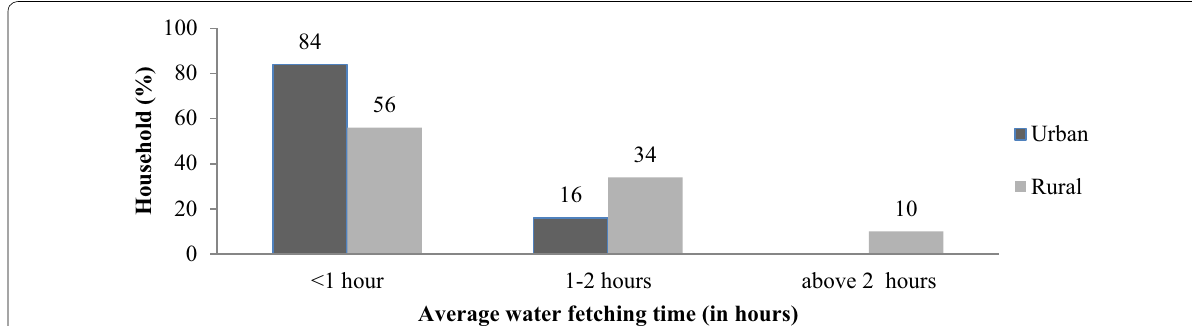
Fig. 1 Classification of Ethiopian households by water fetching time per round trip Source: Author’s compilation based on Central Statistical Agency (2014)